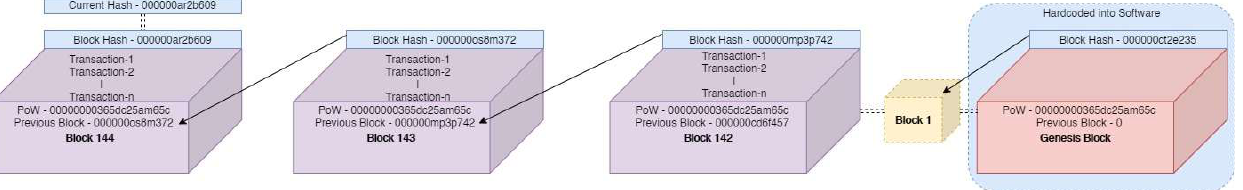
Figure 1. Three-layer architecture for IoT–fog–cloud (IFC) ecosystem. Table 1. Consensus Protocol. PoW—proof of work; PoS—proof of stake; PoET—proof of elapsed time; BFT—Byzantine fault tolerant.